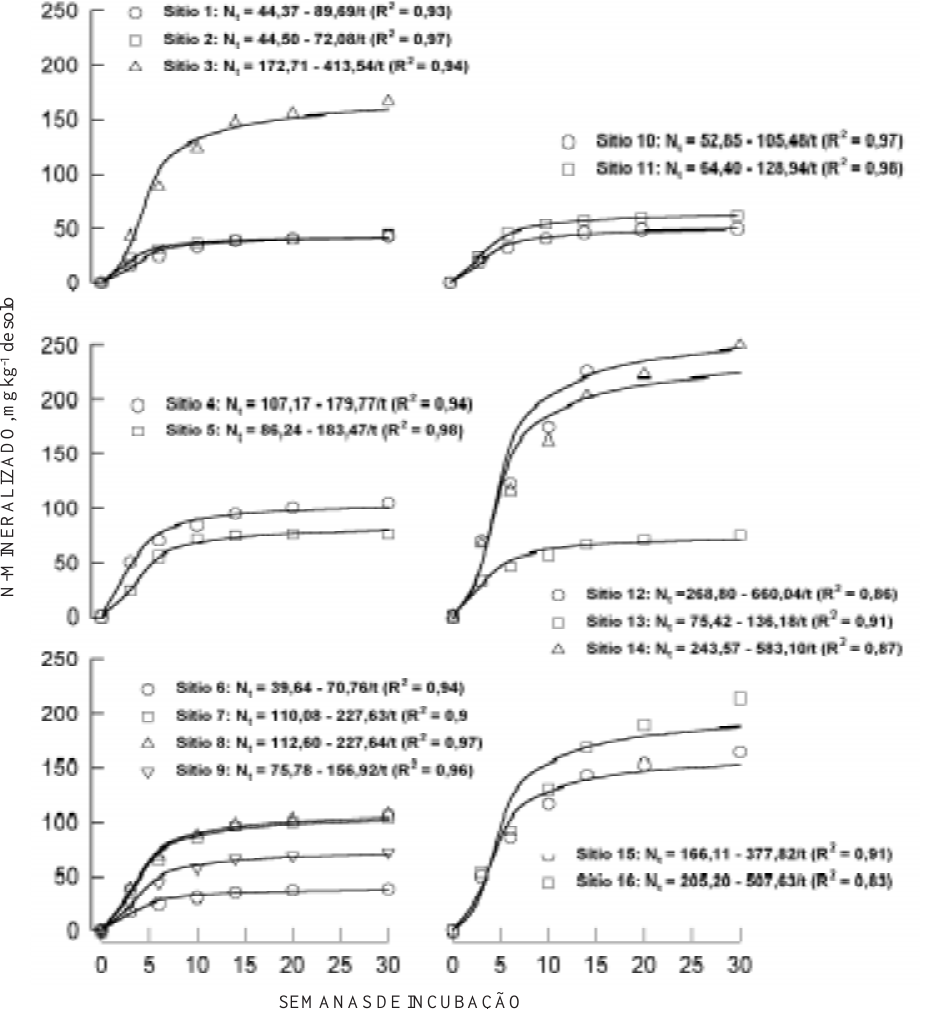
SEMANAS DE Figura 2. Curvas de mineralização anaeróbia de N na camada de 0-15 cm dos solos amostrados nos diversos sítios florestais. Todos os valores dos coeficientes de determinação são significativos a 1%.